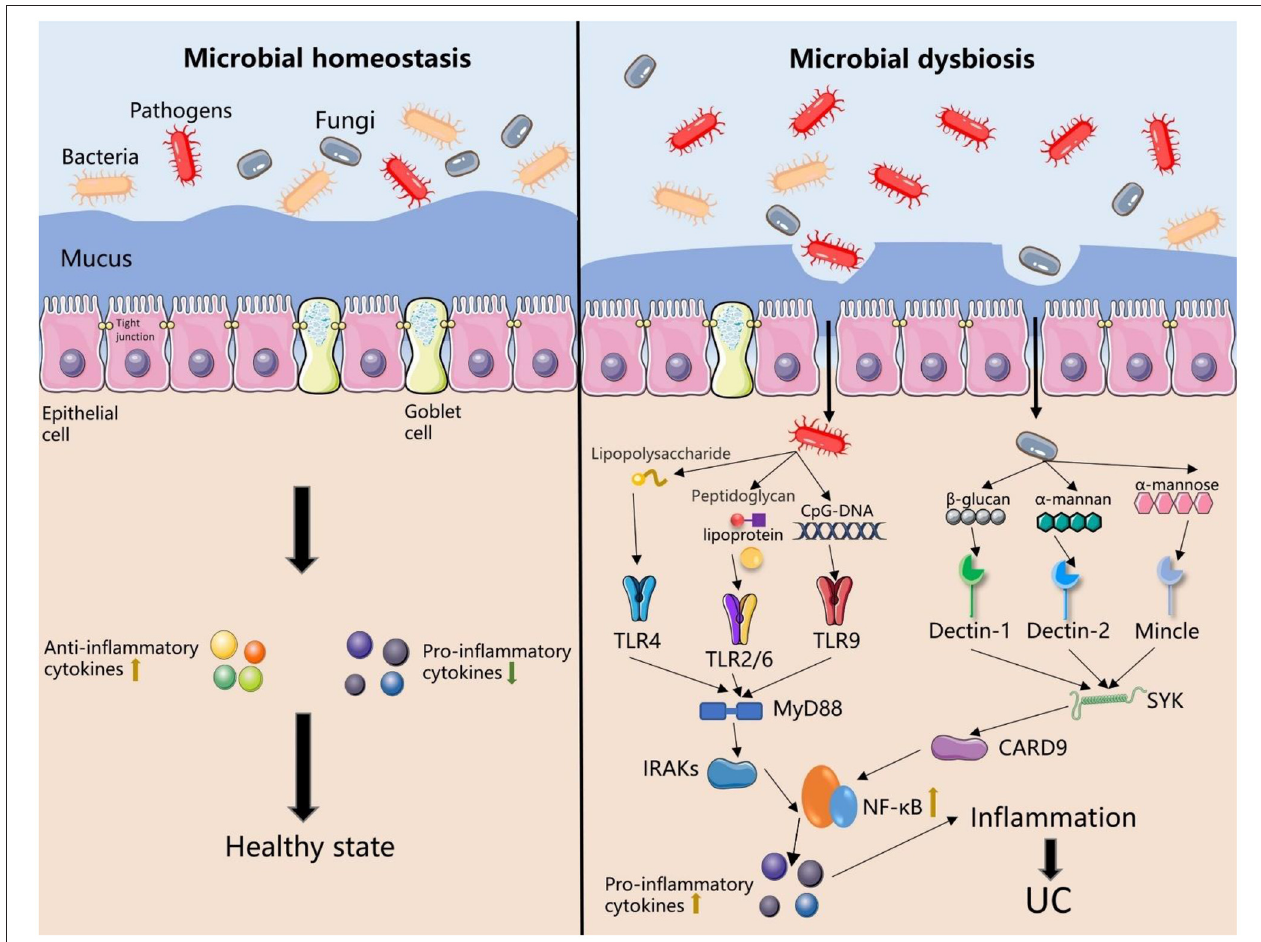
FIGURE 2 | The dysbiosis of intestinal microbiota (bacteria and fungi) results in the occurrence of UC. Under the influence of risk factors, intestinal microbial homeostasis is disrupted. The dysbiosis of microbiota leads to changes in the tight junctions between intestinal epithelial cells, damage of intestinal epithelial barrier, disruption of the mucus layer, and an increase of intestinal permeability. Symbiotic microorganisms and pathogens cause direct damage to the intestinal wall. Furthermore, the main components of the bacterial cell wall (lipopolysaccharide, peptidoglycan, and lipoprotein) are recognized by TLRs, and C-type lectin receptors recognize the components of the fungal cell wall ( β -glucan, α -mannan, and α -mannose). After recognition of the antigen, these receptors induce downstream signaling and activate the NF- κ B signaling pathways, further induce abnormal immune responses in the host and ultimately leading to the occurrence of UC.TLR, Toll-like receptor; MyD88, Myeloid differentiation factor 88; IRAK, interleukin-1 receptor-associated kinase; NF- κ B, nuclear factor κ B; Mincle, Macrophage-inducible C-type lectin; SYK, spleen tyrosine kinase; CARD9, caspase recruitment domain family member